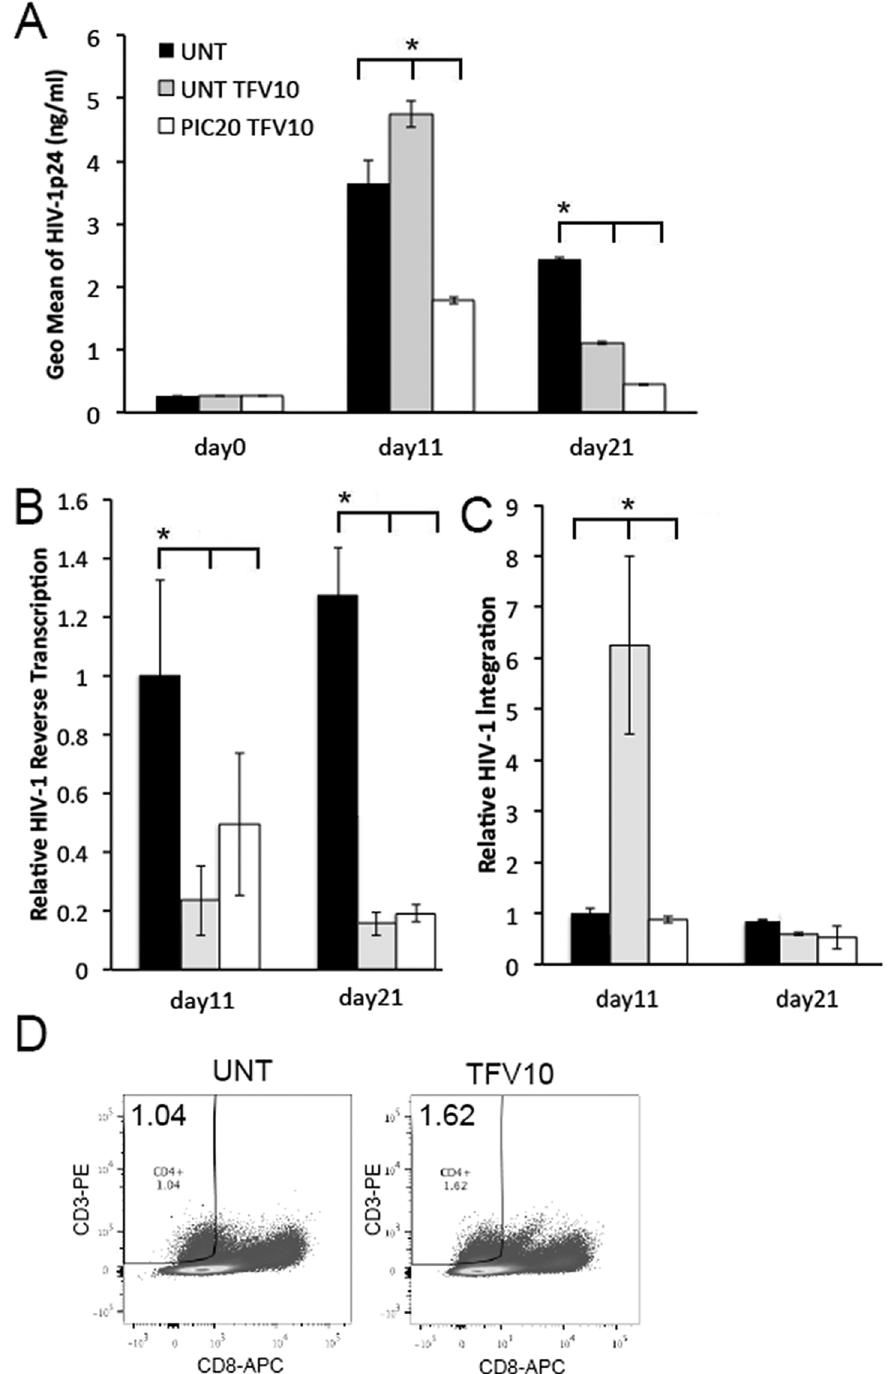
Fig 6. Poly (I:C) improves the efficacy of TFV in cervical tissues. (A) HIV-1 p24 levels (ng/ml) in HIV-1 infected cervical tissues left untreated or treated with TFV at 10 μ g/ml alone or in combination with poly (I:C) at 20 μ g/ml were evaluated after washing the residual input virus (day 0), and again on days 11 and 21 after infection. (B) Levels of HIV-1 reverse transcription and (C) viral integration in donor matched HIV-1 infected cervical tissues left untreated or treated with TFV at 10 μ g/ml alone or in combination poly (I:C) at 20 μ g/ml were quantified by RT-PCR on days 11 and 21 after infection. All data was normalized to human β -actin. For HIV-1 reverse transcription and integration, day 11 values in untreated control tissues were set to 1. Day 11 values in TFV or TFV/Poly (I:C) treated tissues or days 21 values in untreated; TFV or TFV/Poly (I:C)